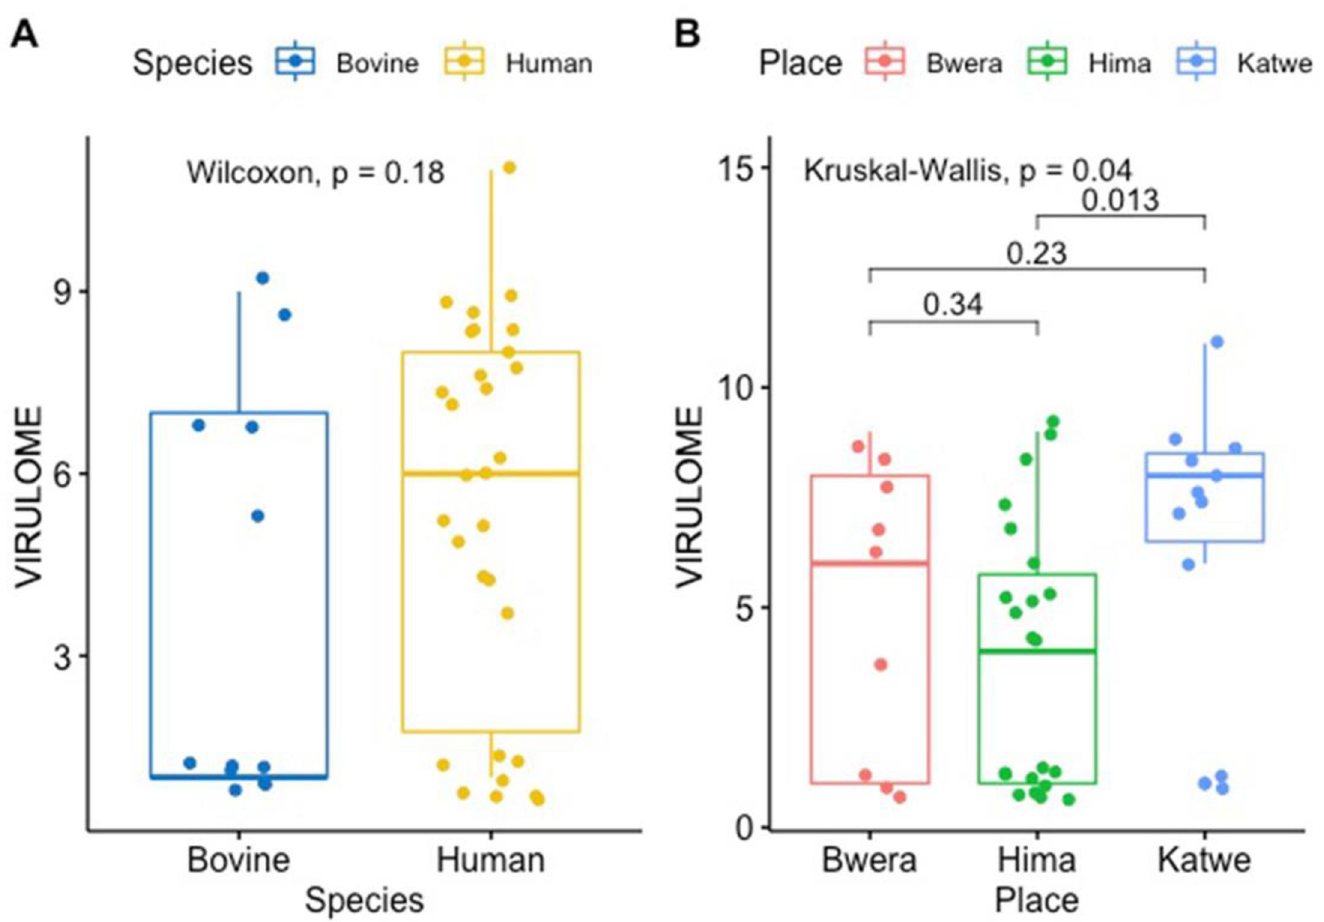
Fig 3. Box plots showing the median values for the number of virulence genes in the two groups along with the interquartile range. The human samples had a significantly higher number of virulence genes compared to bovine samples. The E . coli strains from Katwe had significantly higher number of virulence genes compared to Bwera and